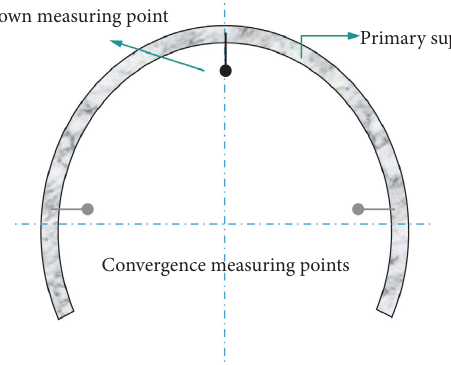
Figure 19: Tunnel deformation measuring points.